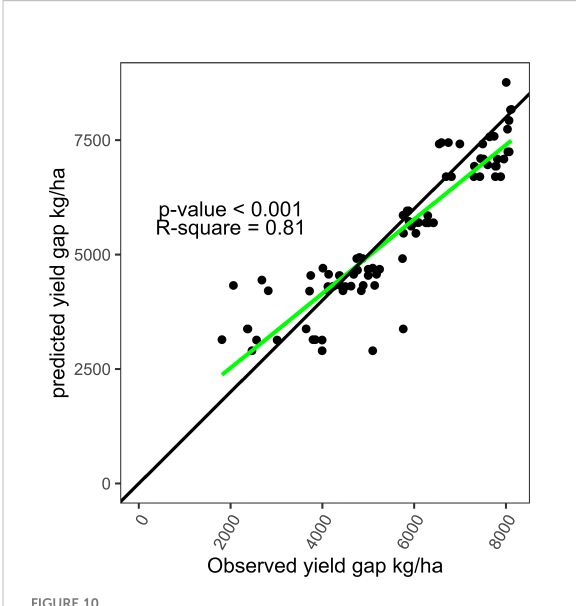
FIGURE 10 MLR accuracy in explaining the yield gap using soil, fertilizer, and rainfall as variables. The green line corresponds to the regression line, and the black line is the 45-degree line (1:1).